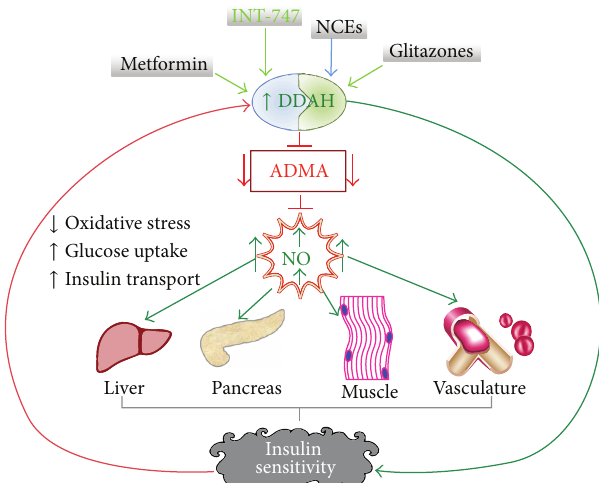
Figure 2: The DDAH/ADMA/NOS pathway and insulin sensitiv- ity. The expression of dimethylarginine dimethylaminohydrolase (DDAH) is upregulated by existing insulin sensitizers such as metformin and pioglitazone or new chemical entities (NCEs). Upregulated DDAH reduces the level of its substrate asymmetric dimethylarginine (ADMA) and increases nitric oxide (NO) produc- tion. NO can directly target insulin-responsive tissues to enhance insulin sensitivity. Increased glucose uptake reduces oxidative stress and in turn alleviates DDAH